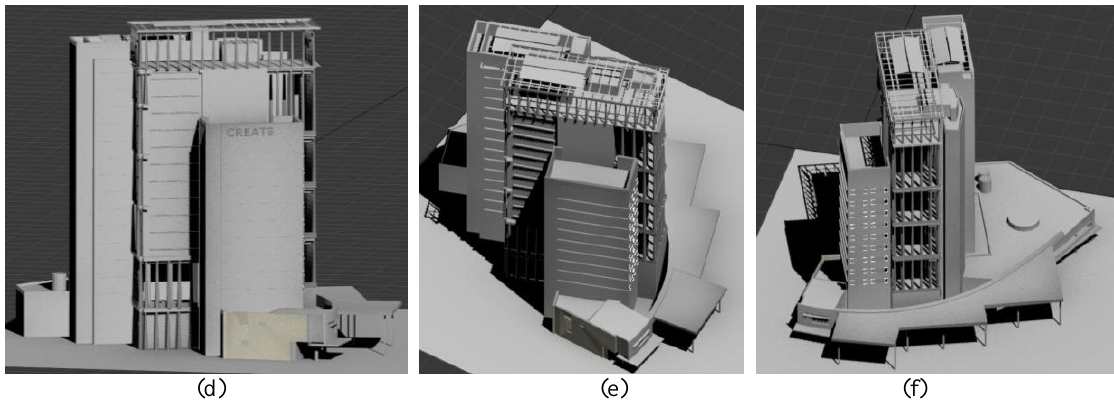
Figure 7: Example of complex CREATE building, (a) an image from UAV; (b) sample point cloud from Mobile Mapping system; (c) terrestrial image sample collected by NIKON D7000; (d)(e)(f) views onto the 3D model of